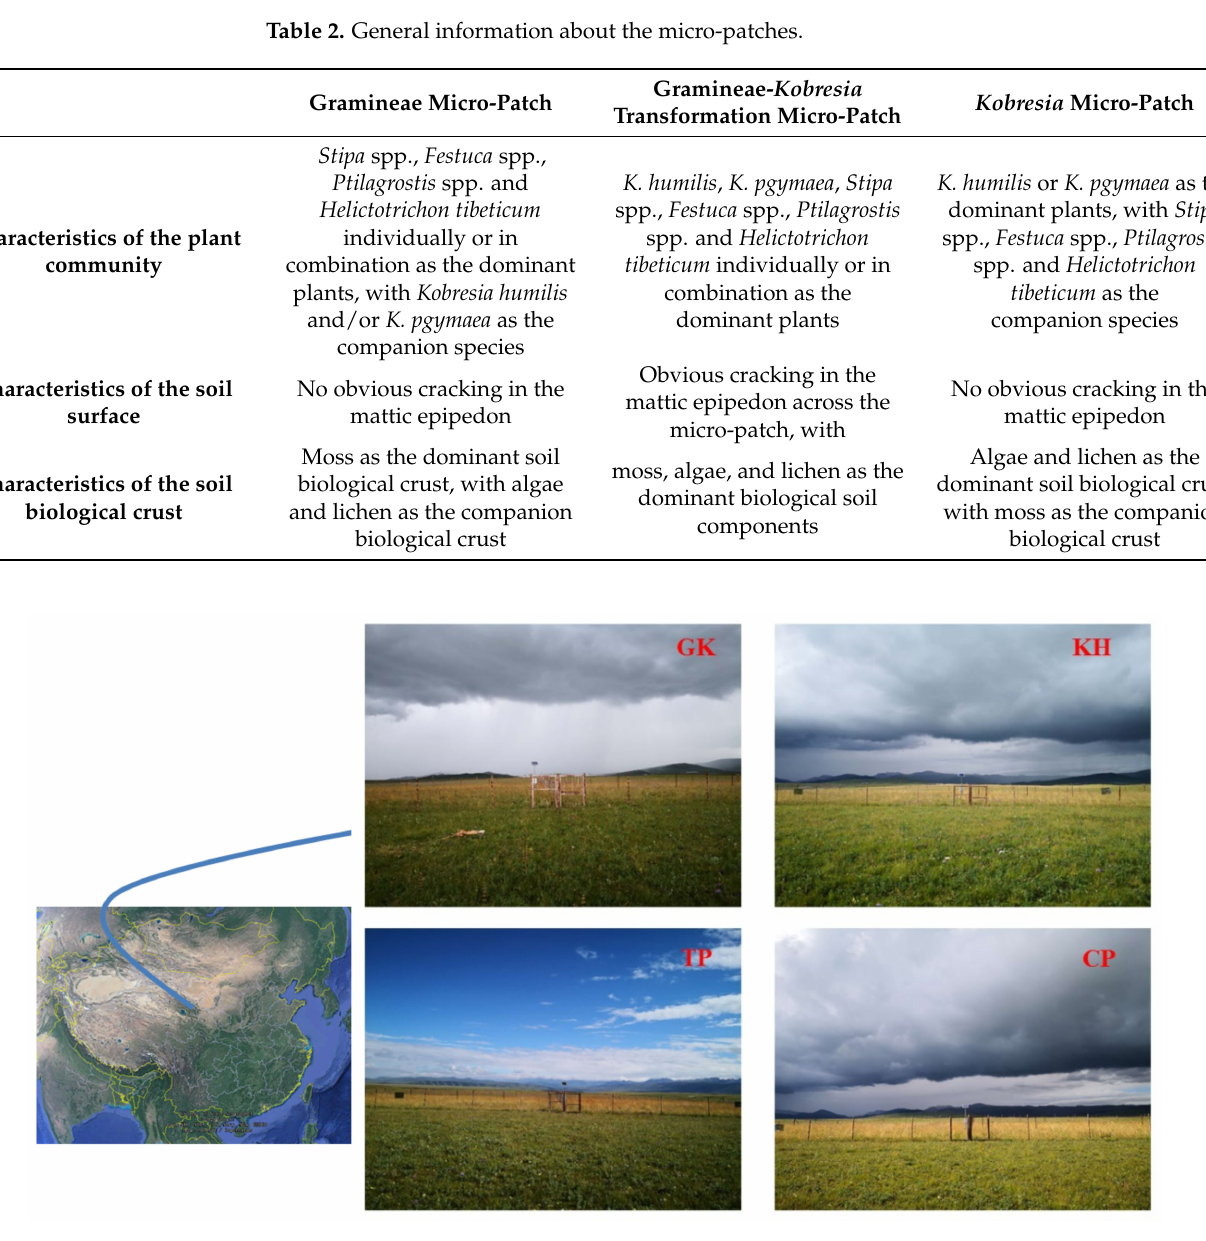
Figure 1. The sampling plots. Note: ( GK ), Gramineae- K. humilis meadow; ( KH ), K. humilis meadow; ( TP ), K. pygmaea meadow with mattic epipedon thickening; ( CP ), K. pygmaea meadow with mattic epipedon cracking. Adapted with permission from Lin et al.